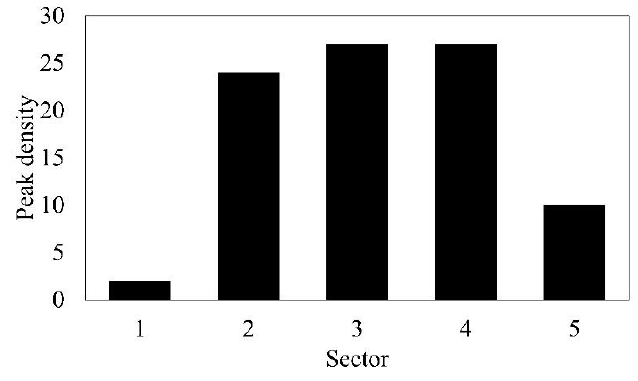
Figure 4. Peak density in all sectors at the center plane (Z = 0).